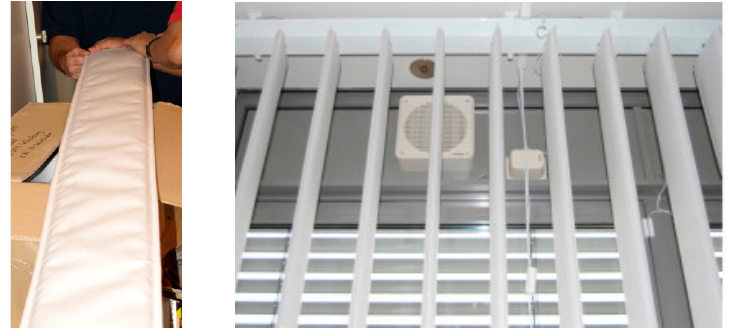
Figure 14. Polycarbonate blinds filled with encapsulated salt hydrate PCM sealed at ends